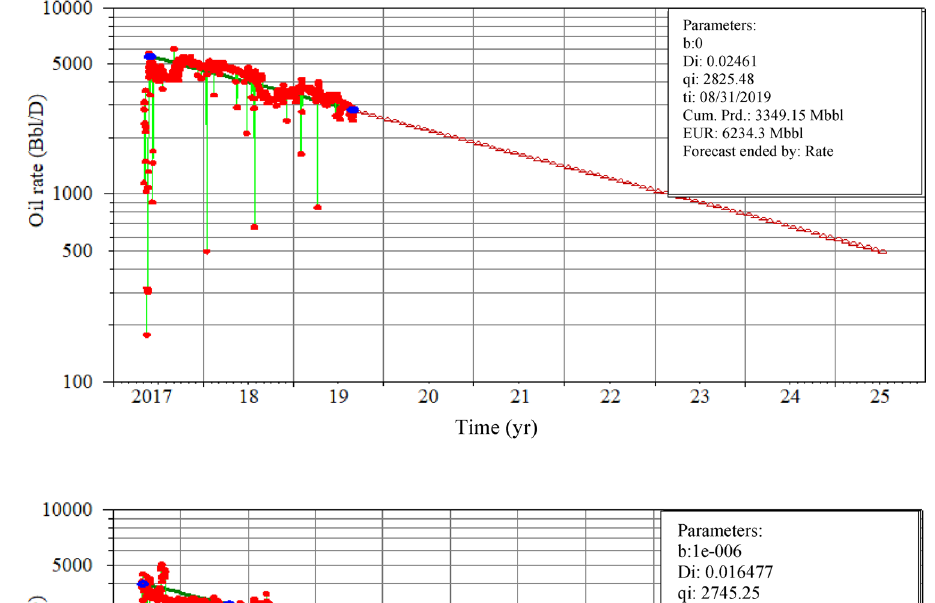
Fig. 9 Rate versus time DCA for candidate W005